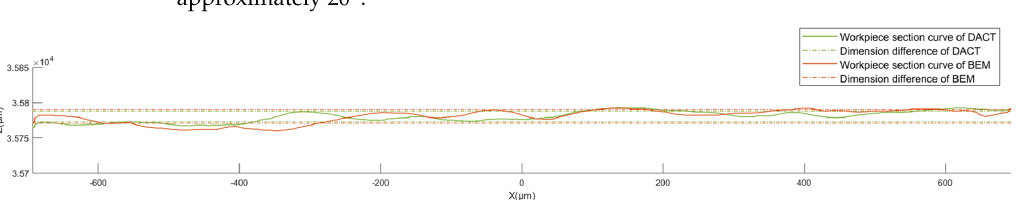
the cross-section profile curve data taken from the ruled surface machined by the DACT